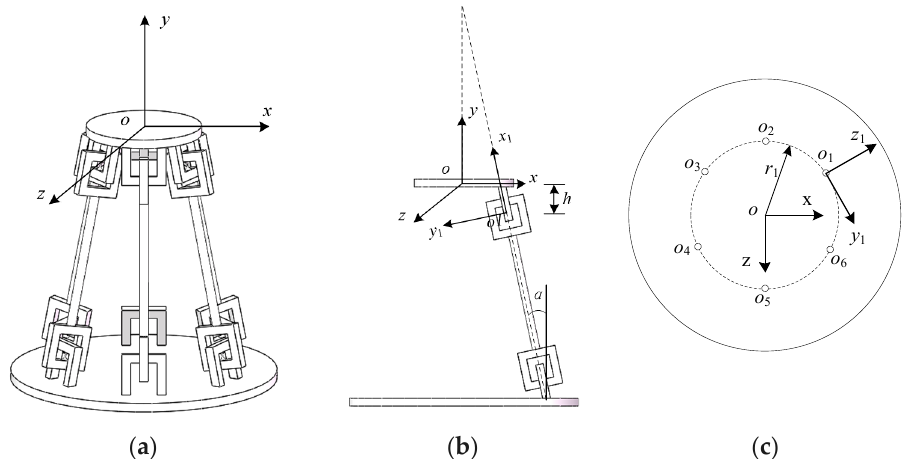
Figure 5. Views of the CPM: ( a ) three-dimensional model of the CPM; ( b ) left view of the CPM; ( c ) top view of the CPM.